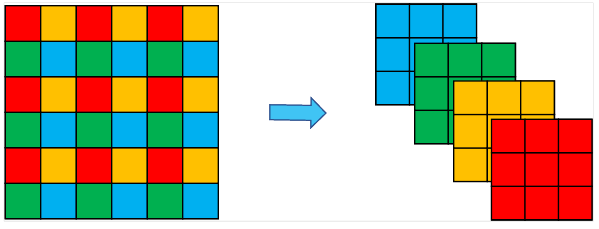
Figure 2. Illustration of the architecture of the Focus module.